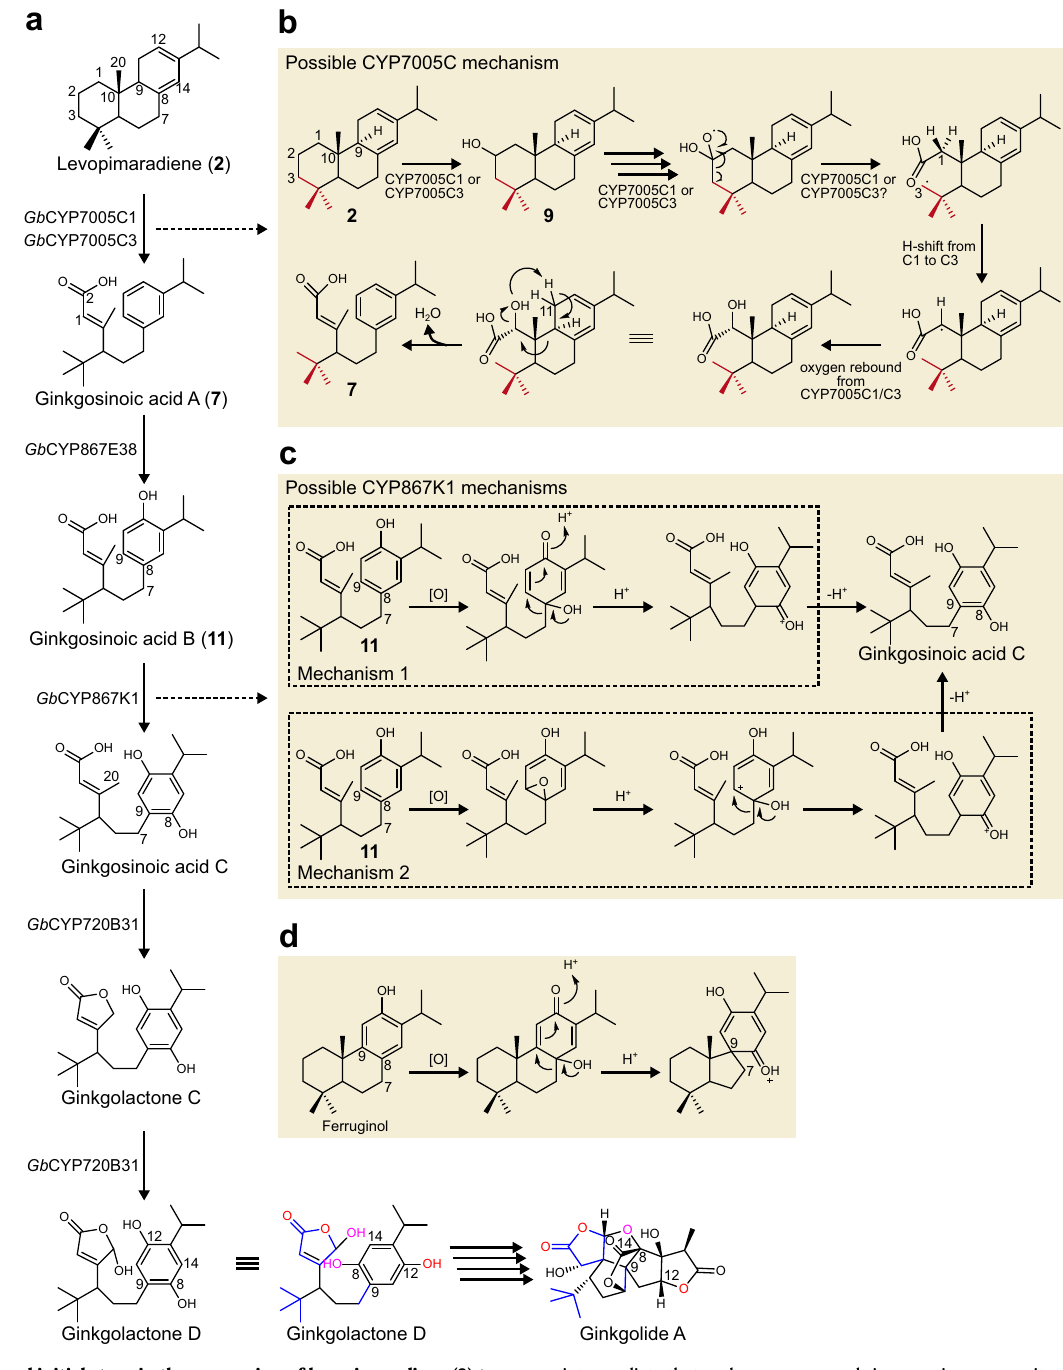
intermediate that undergoes a second ring opening concomitant with water elim- ination. c Possible reaction mechanisms affording the C7 – C8 to C7 – C9 bond-shift in ginkgolide biosynthesis. Mechanism 1 is involving a dienone-phenol rearrange- ment starting with ginkgosinoic acid B. The proposed mechanism amounts to a classicalNIHshift. Mechanism2 depictsanalternativemechanismfortheNIHshift, starting with epoxidation of ginkgosinoic acid B followed by acid-catalyzed open- ing of the epoxide. The localized carbocation is then stabilized by alkyl group migration, ultimately leading to ginkgosinoic acid C. d shows the relevant mechanism as proposed by Schwarz and Arigoni 16 , involving a dienone-phenol rearrangement of ferruginol towards